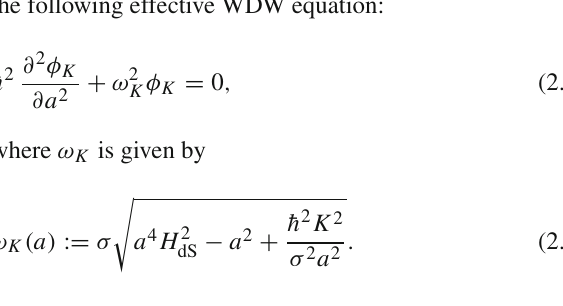
The maximum value of K appearing in the last expression is defined as